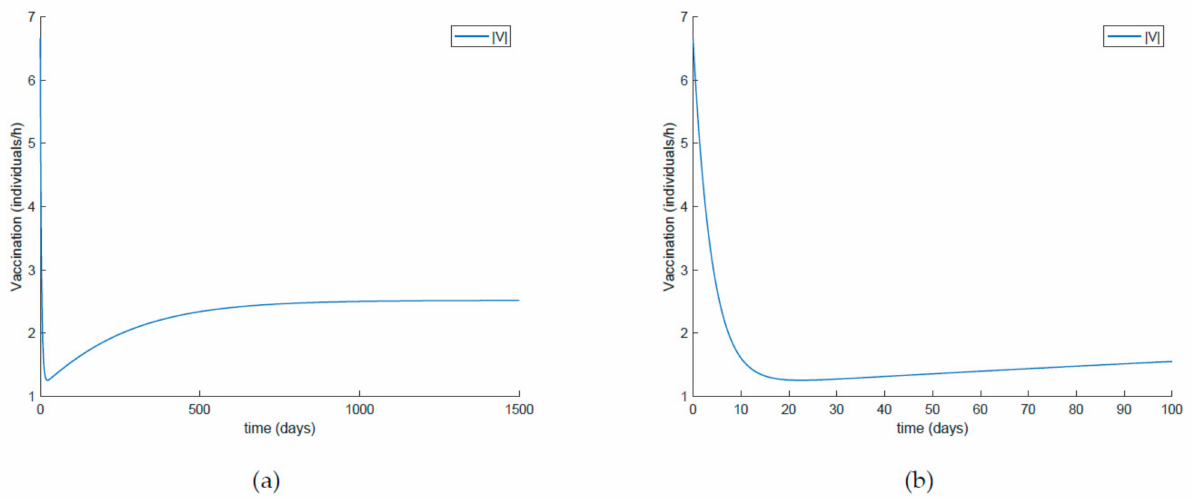
Figure 8. ( a ) Vaccination function when β is fixed through Equation (30) ( λ = 0.9) and a constant vaccination term of 20% of the susceptible individuals is also employed. ( b ) Detail of the simulation for the first 100 days.